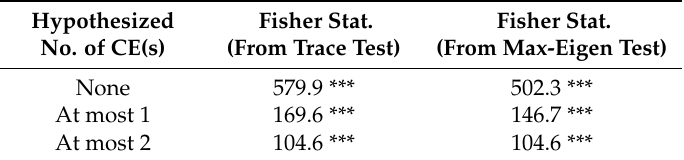
Table 11. Fisher (combined Johansen) test results.